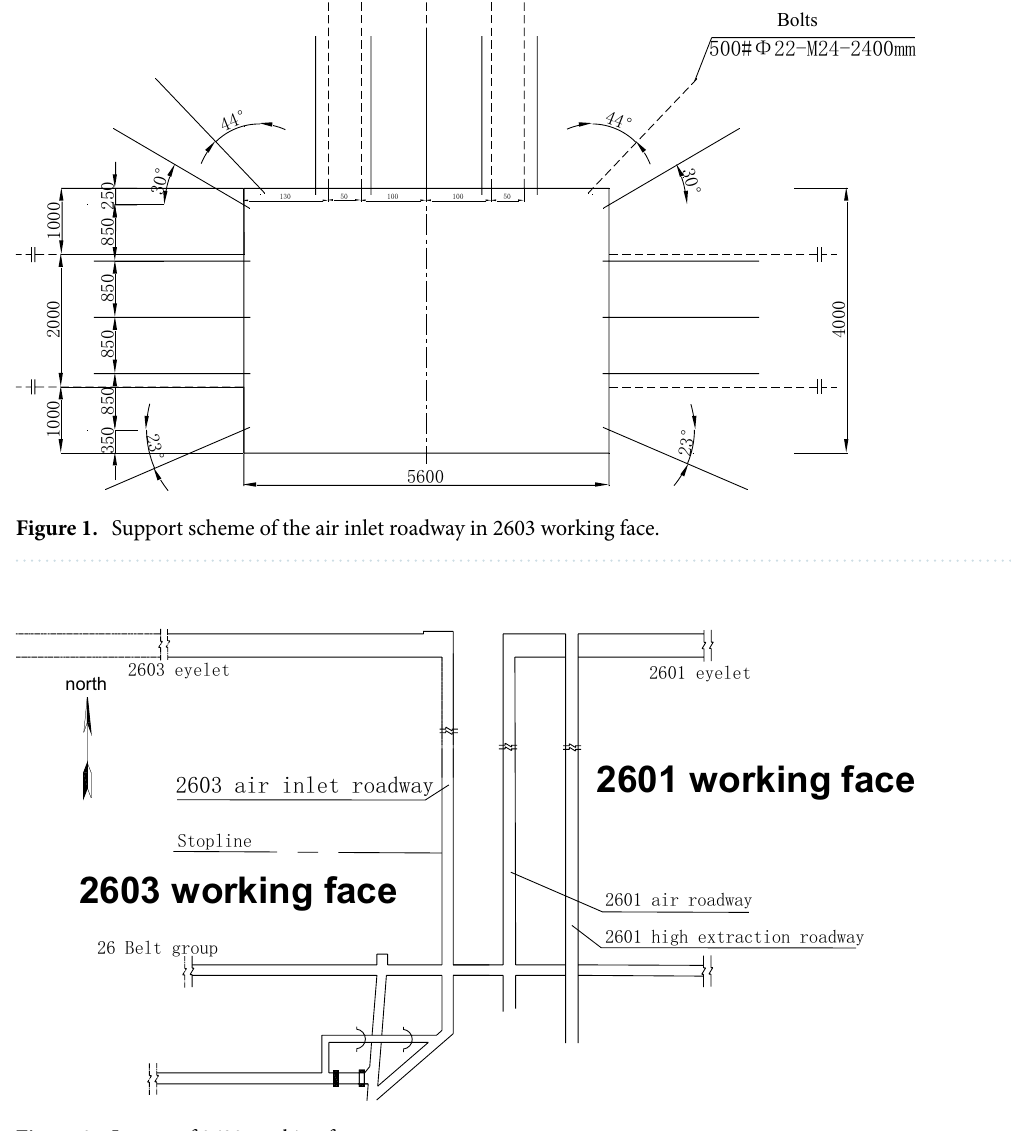
Figure 2. Layout of 2603 working